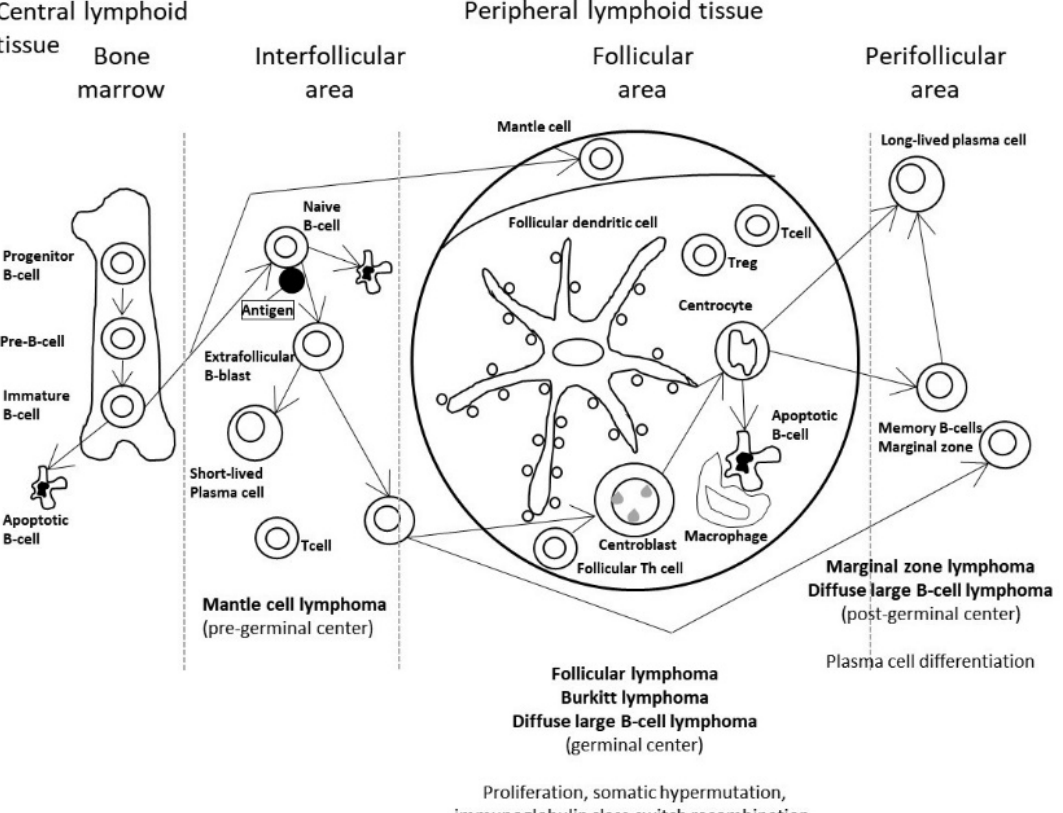
Figure 1. Postulated cell of origin of the non-Hodgkin lymphoma subtypes. In the current theory of the pathogenesis of hematopoietic and lymphoid tissues, B-cell neoplasms correspond to various stages of B-cell differentiation. For example, follicular lymphoma, Burkitt lymphoma, and diffuse large B-cell lymphoma develop (or have a stage of differentiation) from mature B lymphocytes from the germinal centers of follicles of peripheral lymphoid tissues. Of note, follicular lymphoma is characterized by the IGH/BCL2 translocation (t14;18)(q32;q21) that occurs in the bone marrow. Nevertheless, this genetic alteration is not sufficient to generate lymphoma, and additional cumulative changes are necessary.